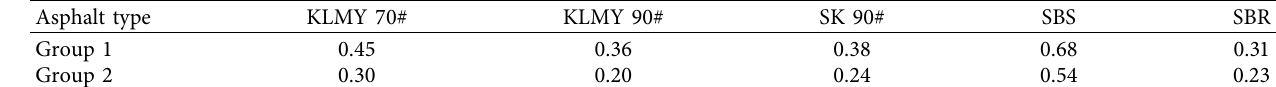
Table 9: Testing results of bond strength.